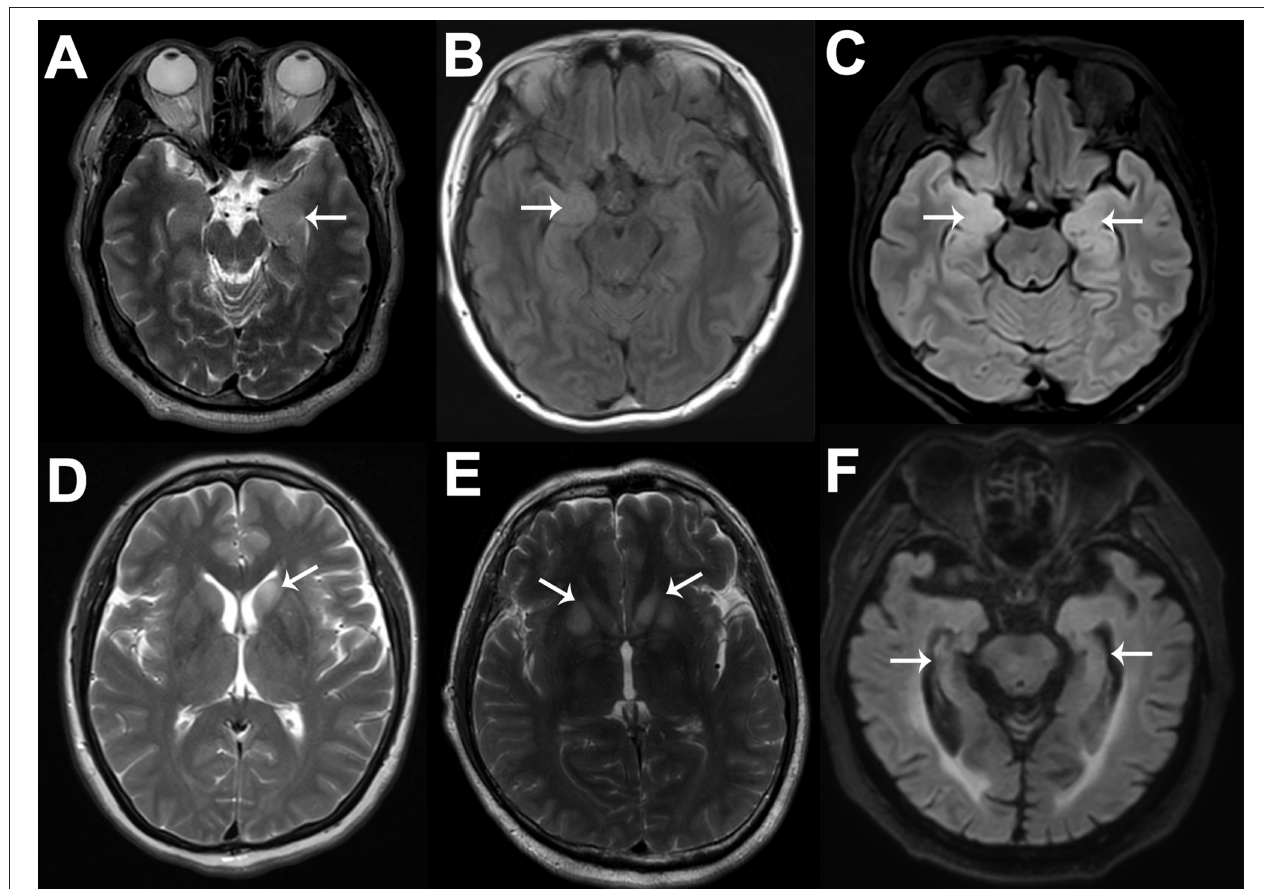
FIGURE 3 | Typical MRI images of six anti-LGI1 encephalitis patients. The cranial MRI images of these anti-LGI1 encephalitis patients were not exactly the same. Six patients are illustrated here. As shown by the white arrows, increased signals on MRI fluid-attenuated inversion recovery or T2 sequences can be seen in the left MTL (A) , right MTL (B) , bilateral MTL (C) , left BA (D) , and bilateral BA (E) , and hippocampal atrophy can be seen (F) . MRI, magnetic resonance imaging; LGI1, leucine-rich glioma-inactivated protein 1; MTL, medial temporal lobe; BA, basal